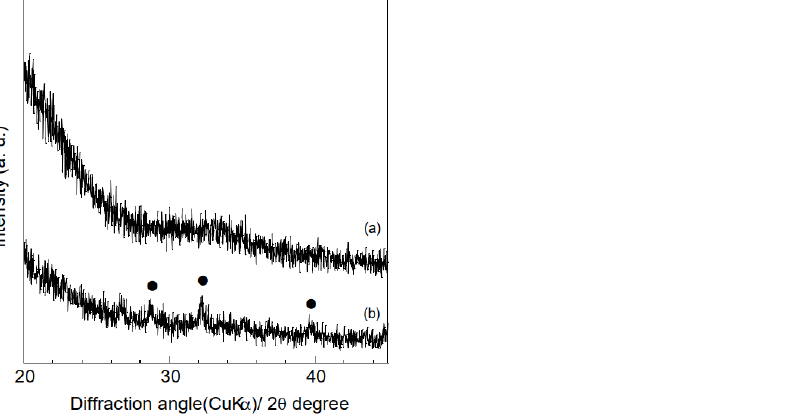
Figure 3. XRD patterns of the ( a ) polymer and ( b ) composite samples. ( • ) Hydrogarnet.